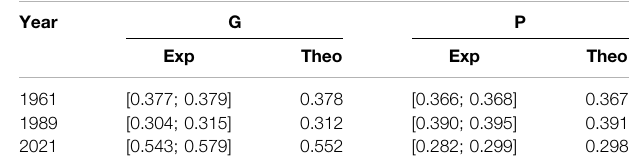
TABLE 7 | Inequality measures for the studied years: the Gini ( G ) index and the Pareto-point ( P